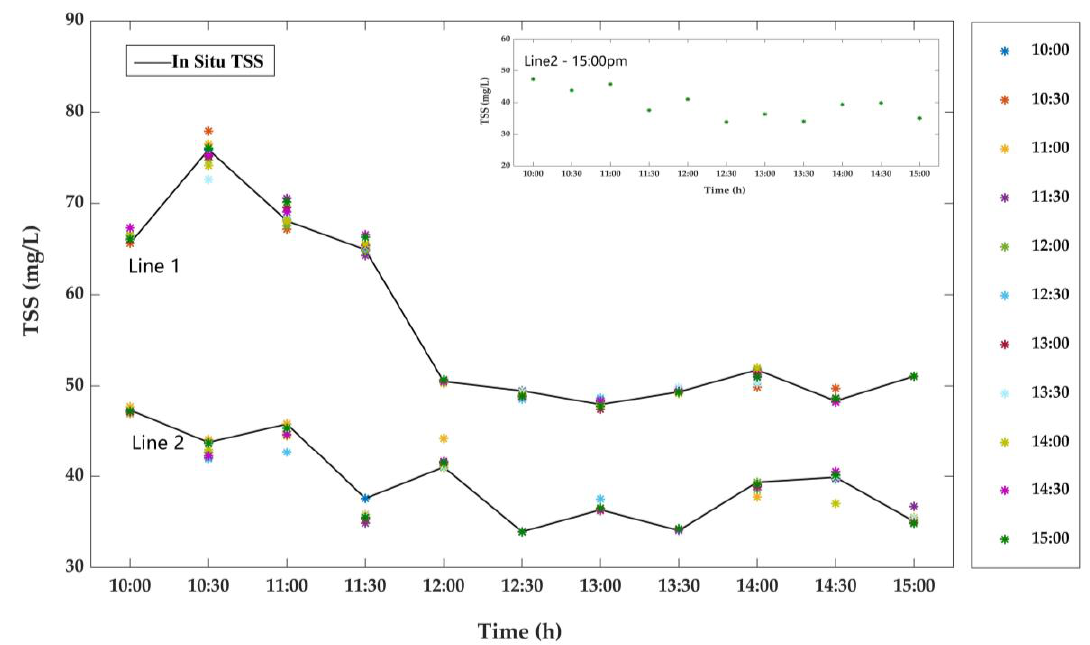
Figure 5. Prediction of TSS by GRNN-based multi-parameters forecasting model in a sunny-day dataset. Lines 1 and 2 show predicted TSS at different concentration ranges, respectively.